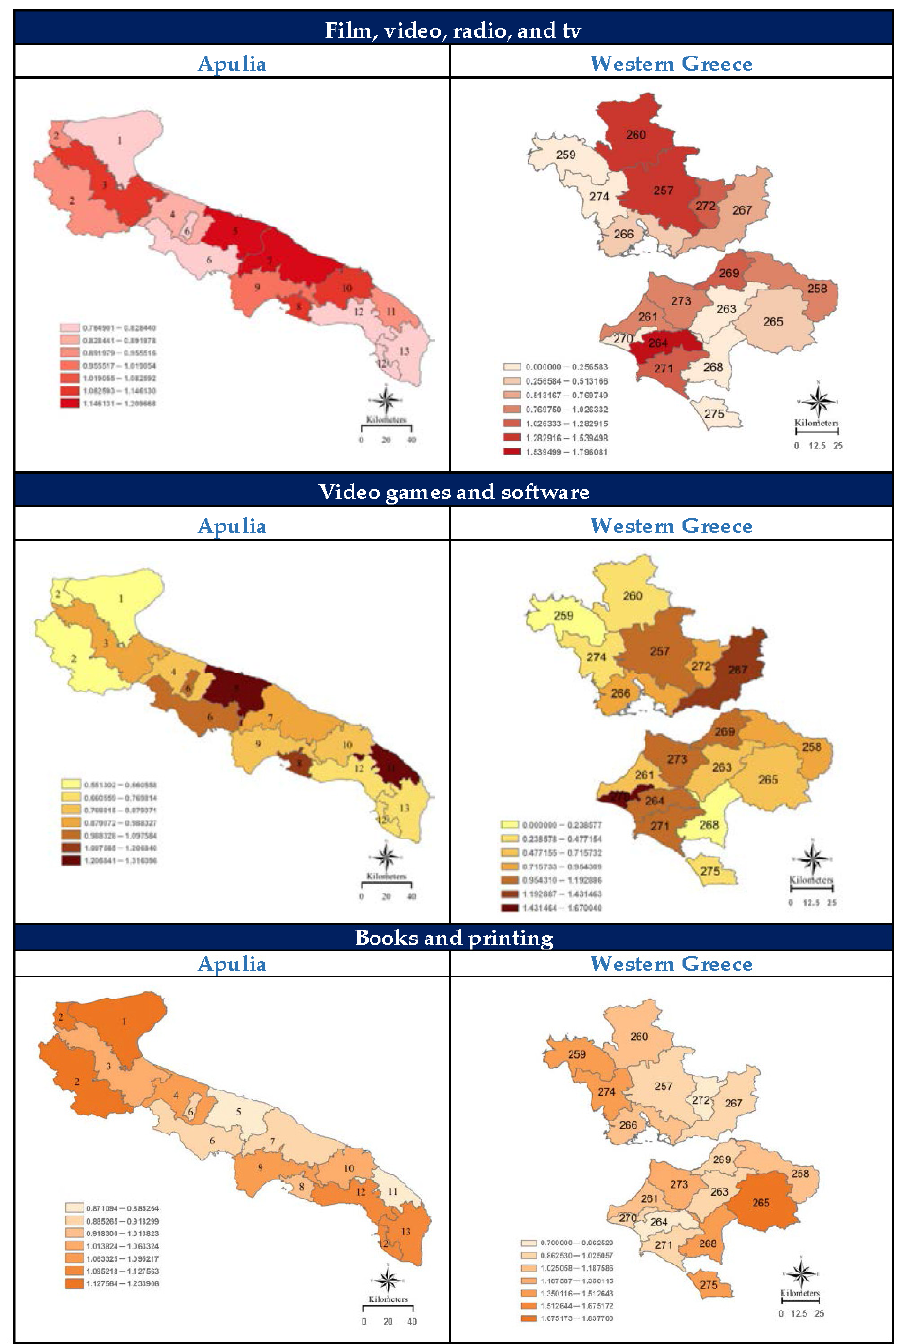
Figure 1. Regional specialization in the Cultural Industries sector. Apulia: 1—Gargano; 2—Monti Dauni; 3—Tavoliere; 4—Puglia Imperiale; 5—Città Metropolitana; 6—Alta Murgia; 7—Murgia Dei